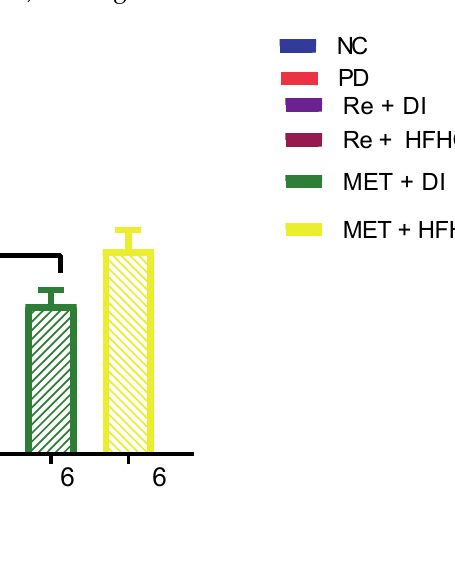
Figure 8. Plasma KIM-1 concentration in normal control (NC), prediabetic control (PD), metformin and diet intervention (MET + DI), metformin and high-fat/high-carbohydrate diet (MET + HFHC), rhenium (V) compound and diet intervention (Re + DI) and rhenium (V) compound and high- fat/high-carbohydrate diet (Re + HFHC) groups after 12 weeks of treatment. Values are presented as means ± SEM (n = 6). (cid:70) p < 0.05 in comparison with NC; α p < 0.05 in comparison with PC, MET + DI, MET + HFHC, Re + DI and Re + HFHC.